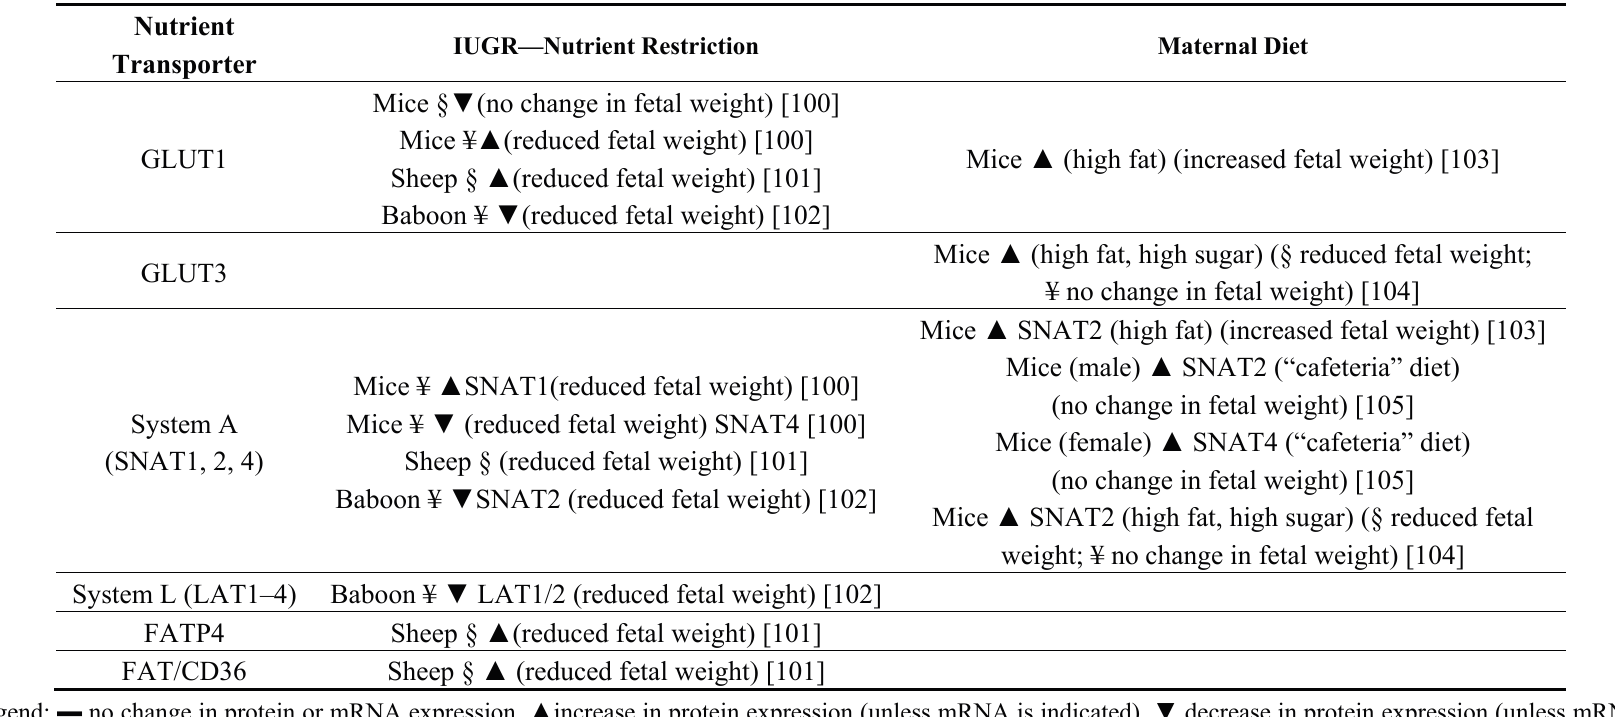
Table 2. Changes in expression level (protein or mRNA) and activity of the glucose, amino acid and fatty acid transporters in the placenta in animal models of different pregnancy conditions 1,2